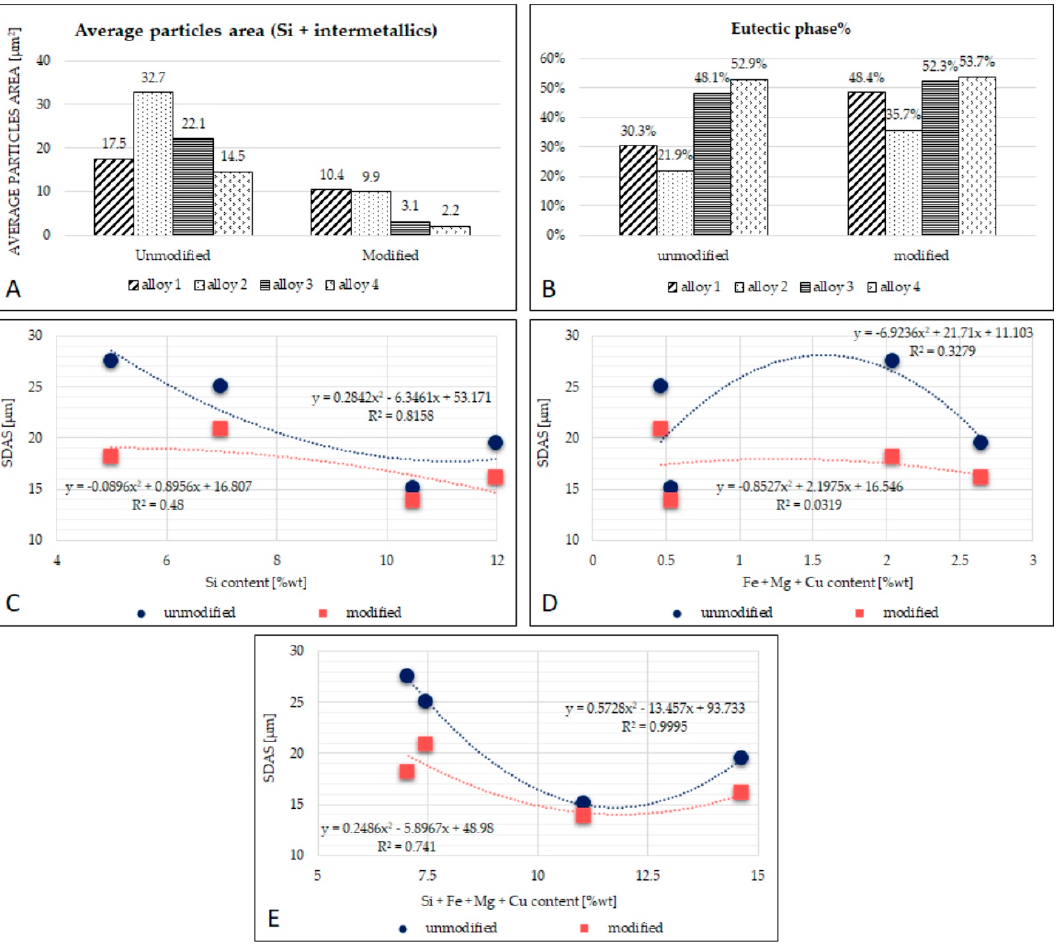
Figure 5. ( A ): Graphical representation of the average particle area; ( B ): graphical representation of the percentage of eutectic phase; ( C ): the relation between average Si content and SDAS; ( D ): the relation between average Fe + Mg + Cu content and SDAS; ( E ): the relation between average Si + Fe + Mg + Cu content and SDAS.